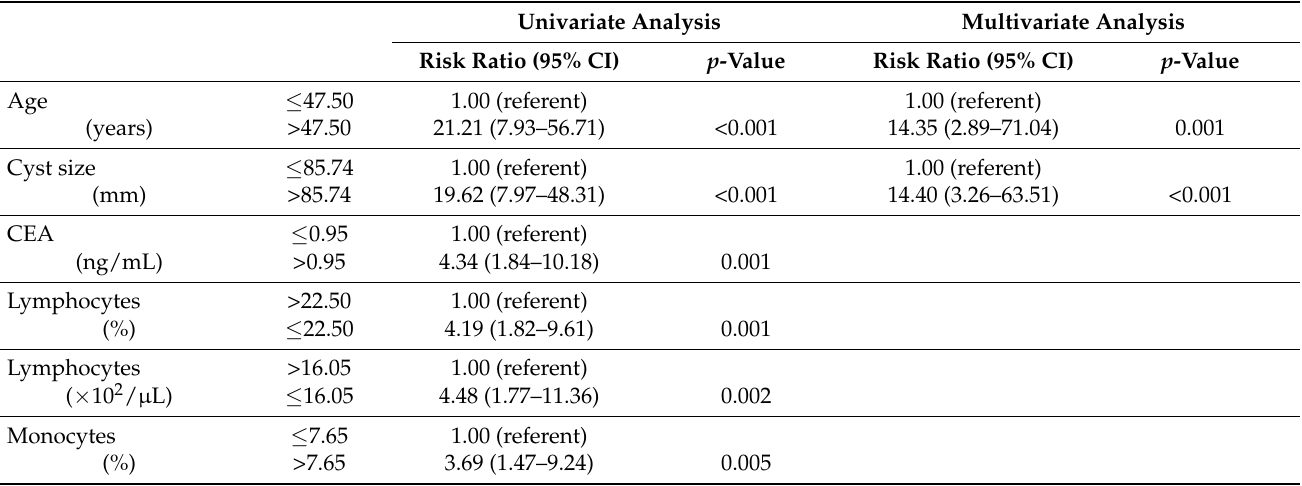
Table 5. Univariate and Multivariate analysis of the predictive factors of EAOC in the current cohort. Univariate Analysis Multivariate